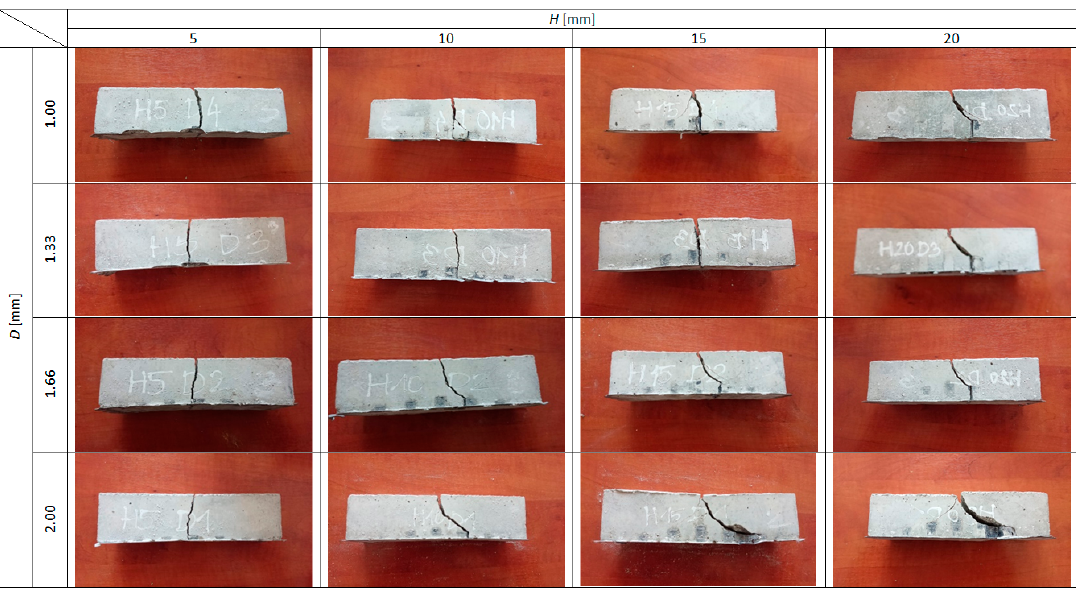
Figure 4. Cracking patterns of ultimately destroyed prism specimens.